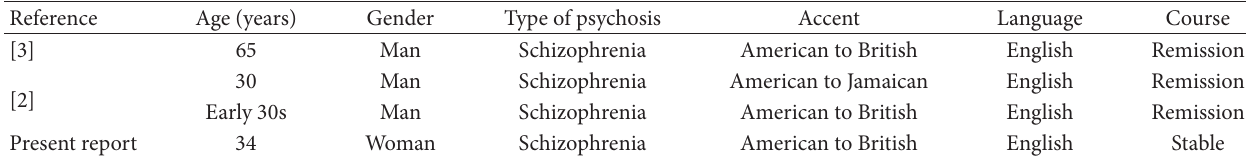
Table 1: Case reports of combined foreign accent syndrome and